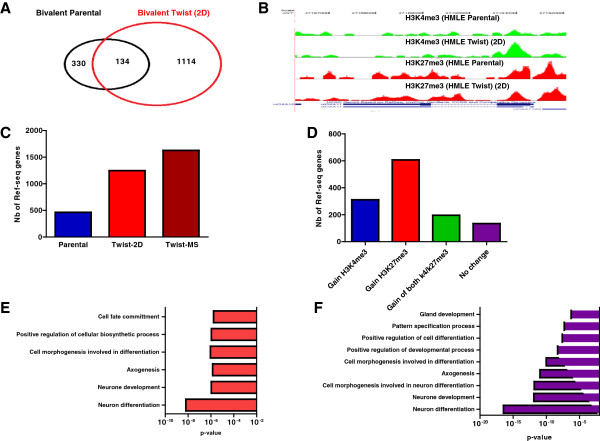
Bivalent genes are highly enriched in mesenchymal cells. (A) Venn diagram of bivalent genes in human mammary epithelial (HMLE) vector cells and HMLE Twist- cells. (B) Landscape of H3K4me3 and H3K27me3 mark for the homeobox gene HOXA11. Note that HOXA11 is marked by H3K27me3 in both epithelial and mesenchymal cells. In HMLE Twist cells, HOXA11 gains H3K4me3 mark in addition to H3K27me3 mark. (C) Bar graph showing the number of bivalent genes in HMLE vector cells, and HMLE Twist cells in a monolayer (Twist-2D) and sphere culture (Twist-MS). (D) Changes in histone modifications among genes becoming bivalent in HMLE Twist cells (Twist-2D) as compared to HMLE vector cells. (E) Gene ontology of newly bivalent genes in HMLE Twist cells cultured in monolayer (Twist-2D). (F) Gene ontology of newly bivalent genes in HMLE Twist cells cultured in spheres (Twist-MS). 2D, monolayer; MS, mammosphere.